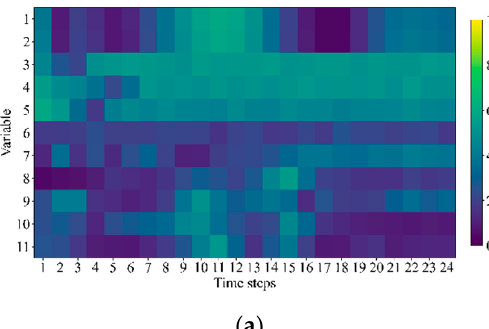
Figure 8. Distance-coded heat map of working condition 2. ( a ) Heat map of operating parameters of atmospheric two-line products. ( b ) Heat map of operating parameters of vacuum two-line products.